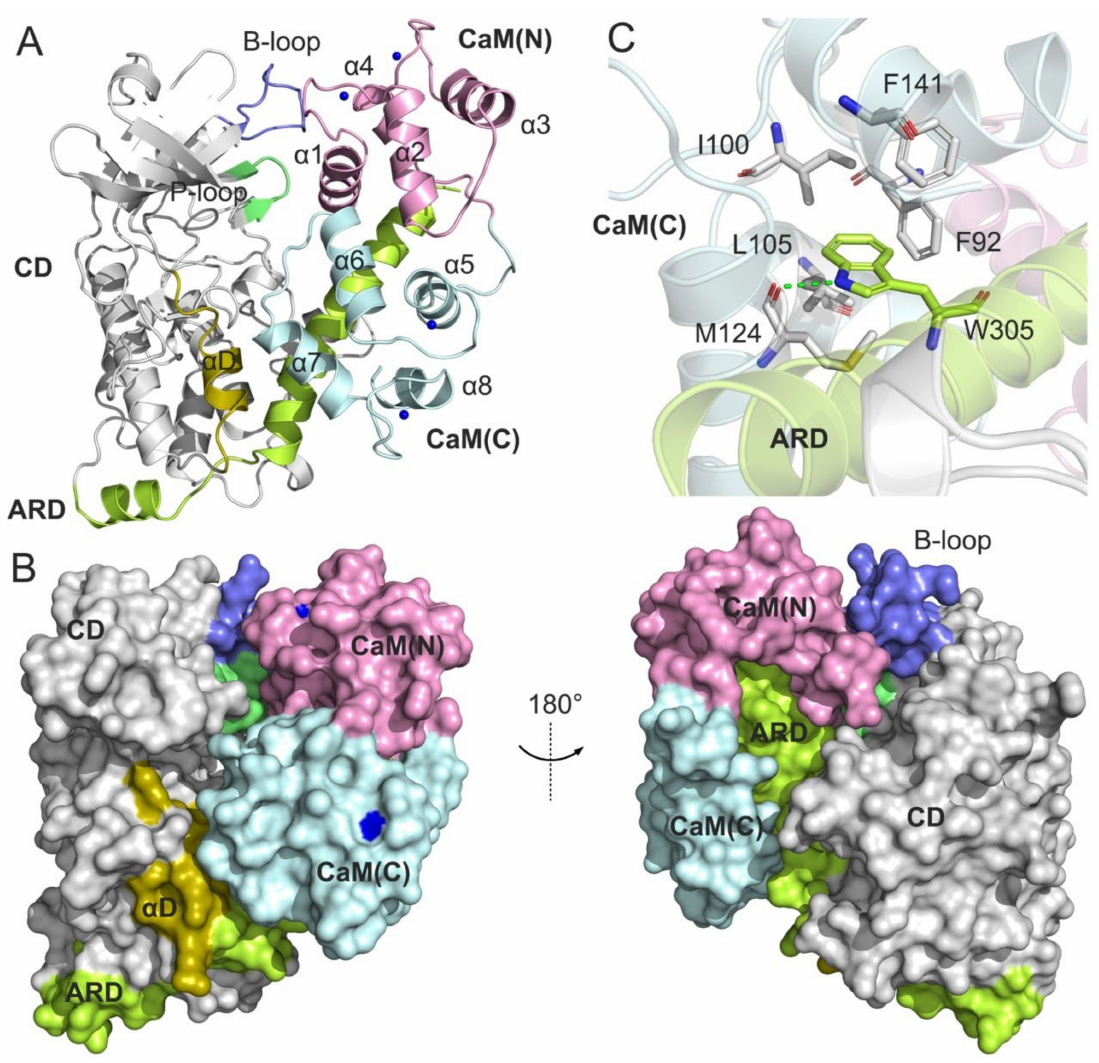
Figure 1. ( A ) A representation of the structural complex of DAPK1–CaM (PDB ID: 2X0G). The catalytic domain (CD) and the autoregulatory domain (ARD) of DAPK1 are colored gray and lemon, respectively. The important basic loop (B-loop), the phosphate-binding loop (P-loop), and the helix α D are colored light blue, lime, and olive, respectively. The N-terminal and the C-terminal CaM are colored pink and light cyan, respectively. Calcium ions are shown by blue spheres. ( B ) Surface representation of the structural complex of DAPK1–CaM. ( C ) The hydrophobic network of Trp305 with the CaM residues. Hydrogen bonds are shown by green dotted